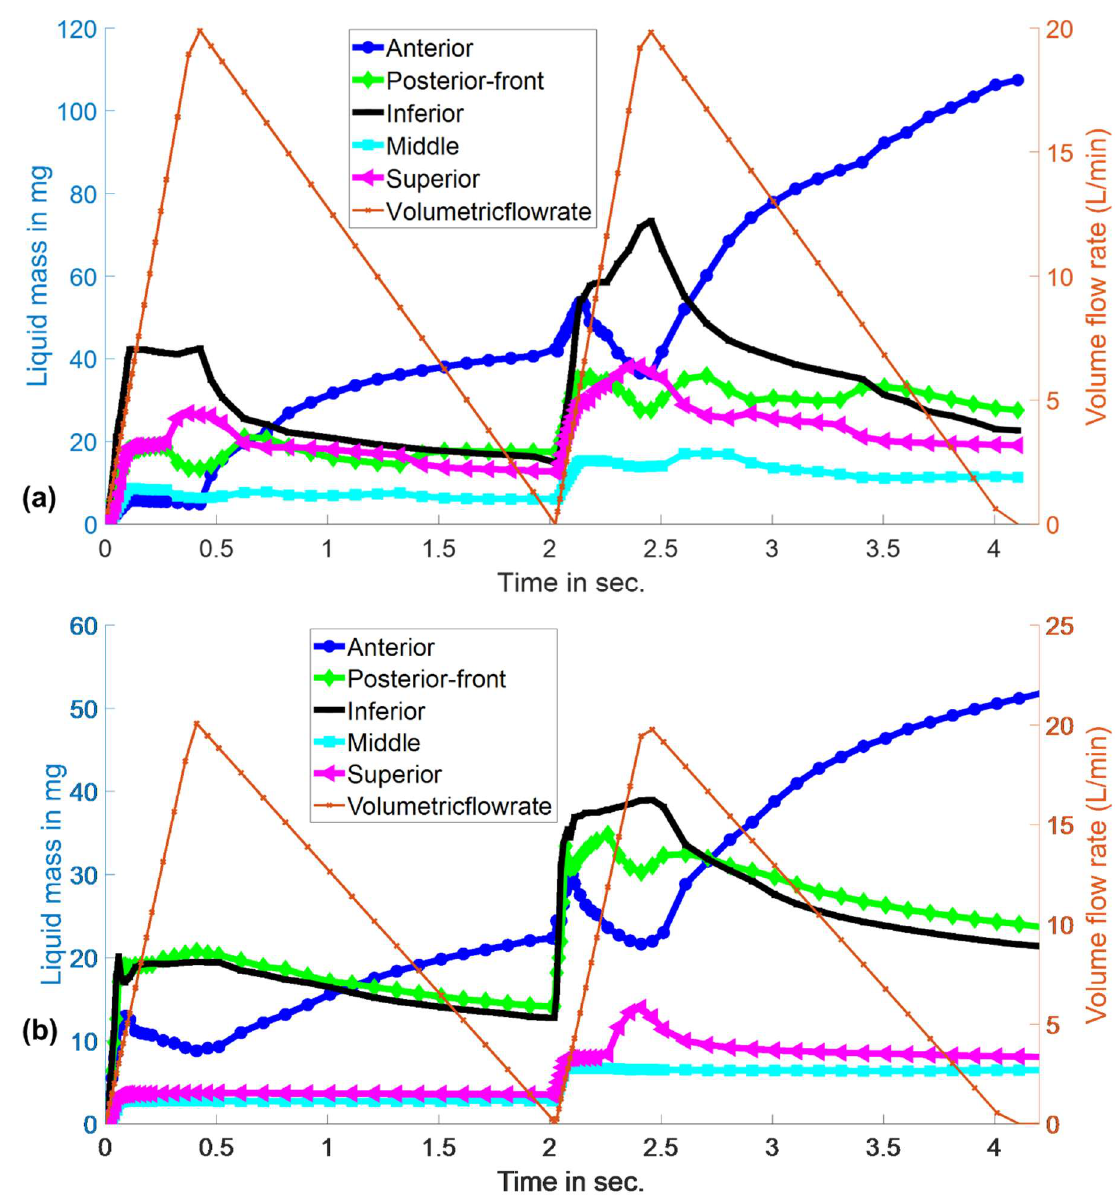
Figure 7. Evolution of ( a ) Flonase and ( b ) Flonase Sensimist spray-liquid mass in specific regions of the nasal airway surface.